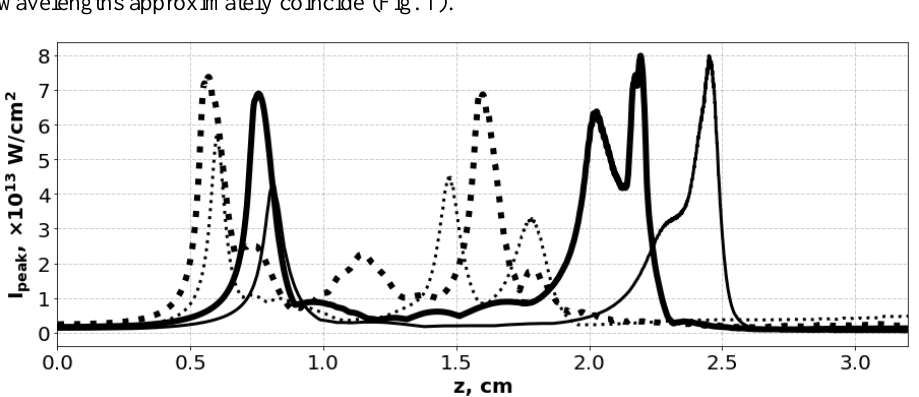
Fig. 1. Optical vortices with topological charges 𝑚 = 1 (solid lines) and 𝑚 = 2 (dotted lines) peak intensity dependence on the propagation distance 𝑧 under self-action in the LiF crystal at central wavelengths 𝜆 0 = 1800 nm (thin lines) and 𝜆 0 = 3000 nm (thick